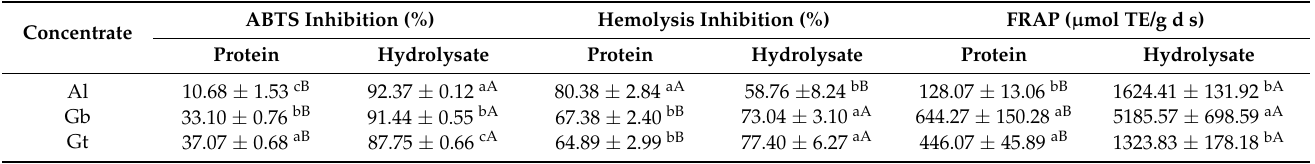
Table 2. Antioxidant activity of protein concentrates obtained from chickpea